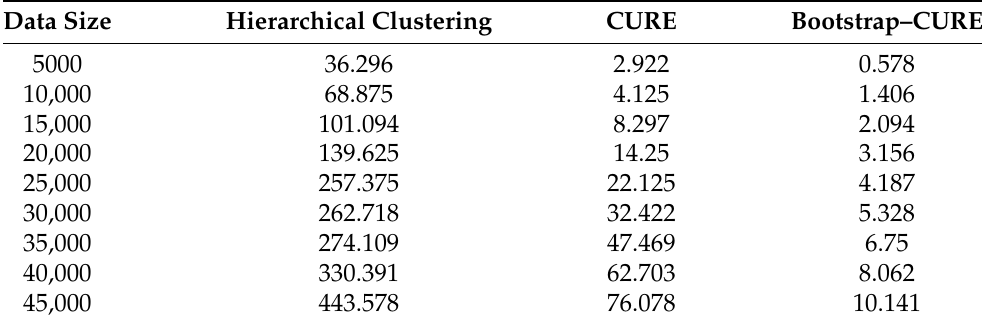
Table 2. CPU time (sec) comparison among hierarchical, CURE and bootstrap–CURE